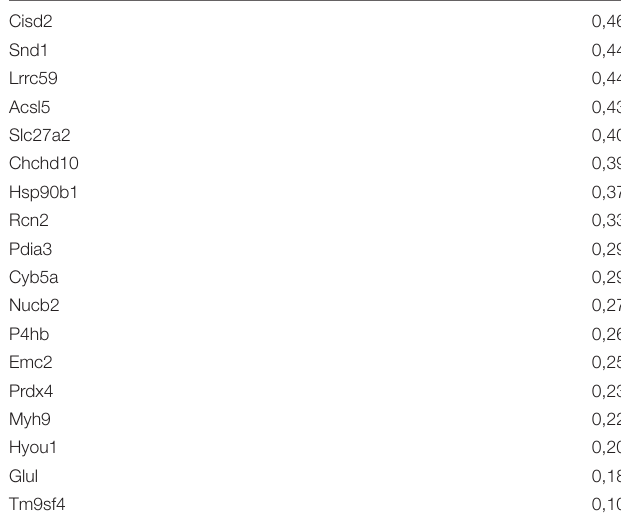
TABLE 2 | Proteins downregulated by MB-6